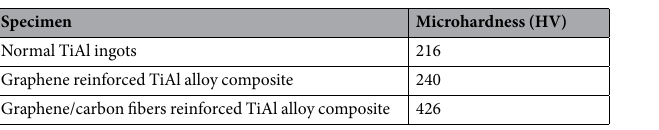
Table 1. Microhardness text of graphene/carbon fibers reinforced TiAl alloy